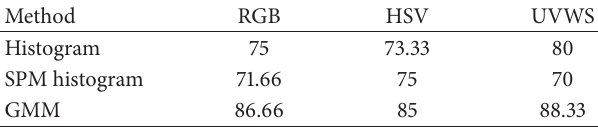
Table 1: The average precision for persons retrieval in location 1.